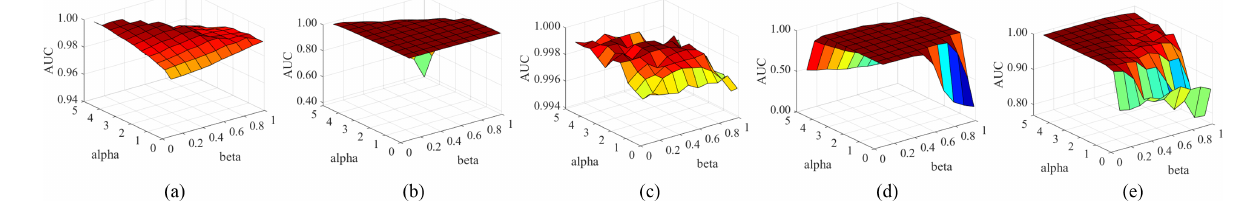
Figure 9. Effects of the weight parameters α and β over AUC values on five images. ( a ) airport-4; ( b ) beach-3; ( c ) urban-2; ( d ) AVIRIS-1; ( e )